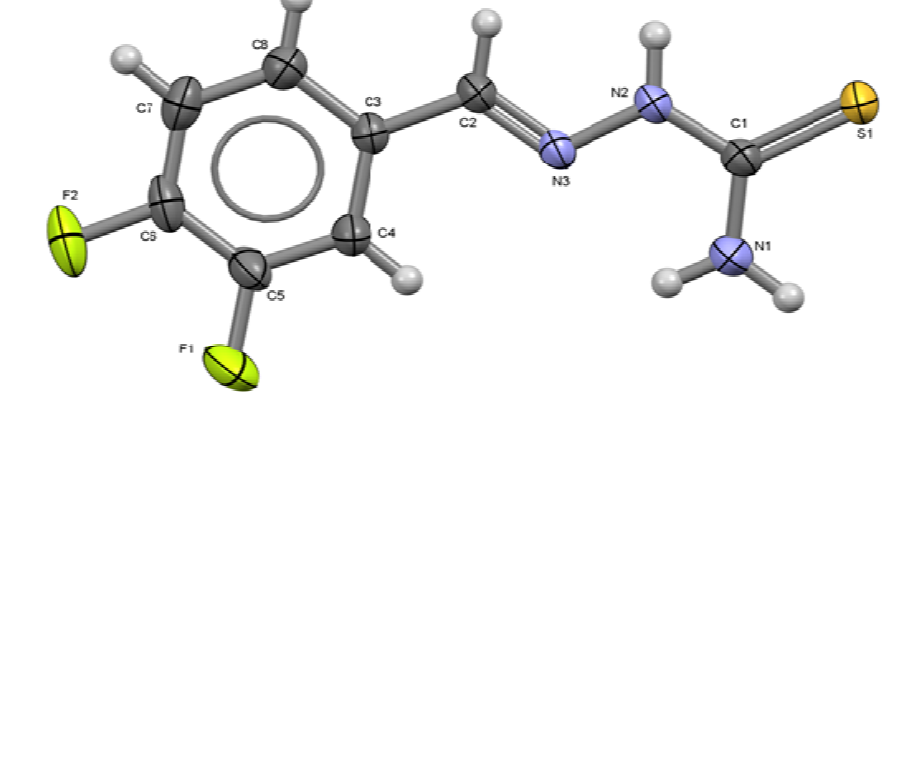
Figure 4. ORTEP drawing of 3,4-C shown at 50% of probability. Selected bond lengths (Å) and angles (°): S1-C1 1.6788(14), C1-N1 1.3261(18), C1-N2 1.3407(17), N2-N31.3773(15),N3-C2 1.2743(17), C2-C3 1.4612(18), C5-F1 1.3478(18), C6-F2 1.3511(16); S1-C1-N1 122.76(11),